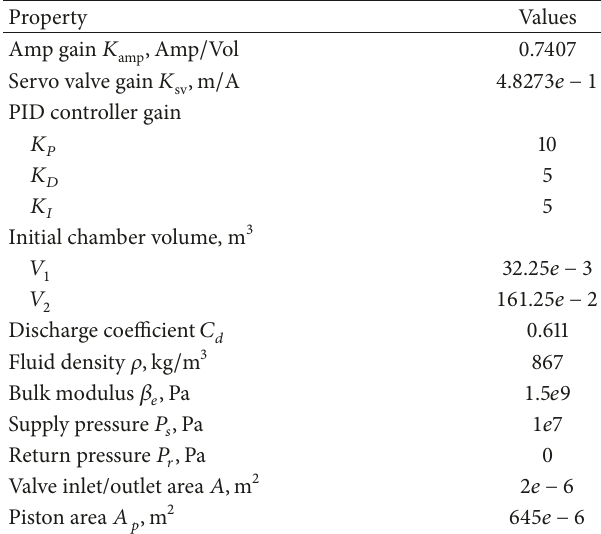
Table 4: Simulation conditions.